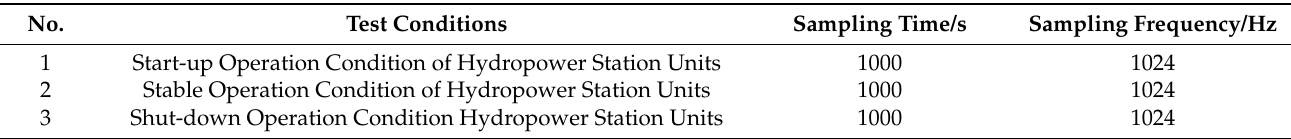
Figure 9. Layout of measuring points. ( ① —top cover; ② —lower frame foundation; ③ —stator foundation; ④ —generator floor). Table 3. Test conditions of powerhouse of hydropower